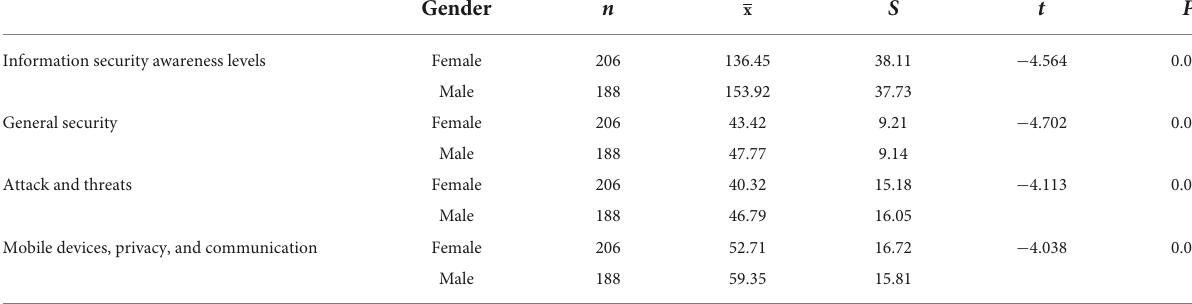
TABLE 3 Teachers’ information security awareness levels and sub-factors relations by